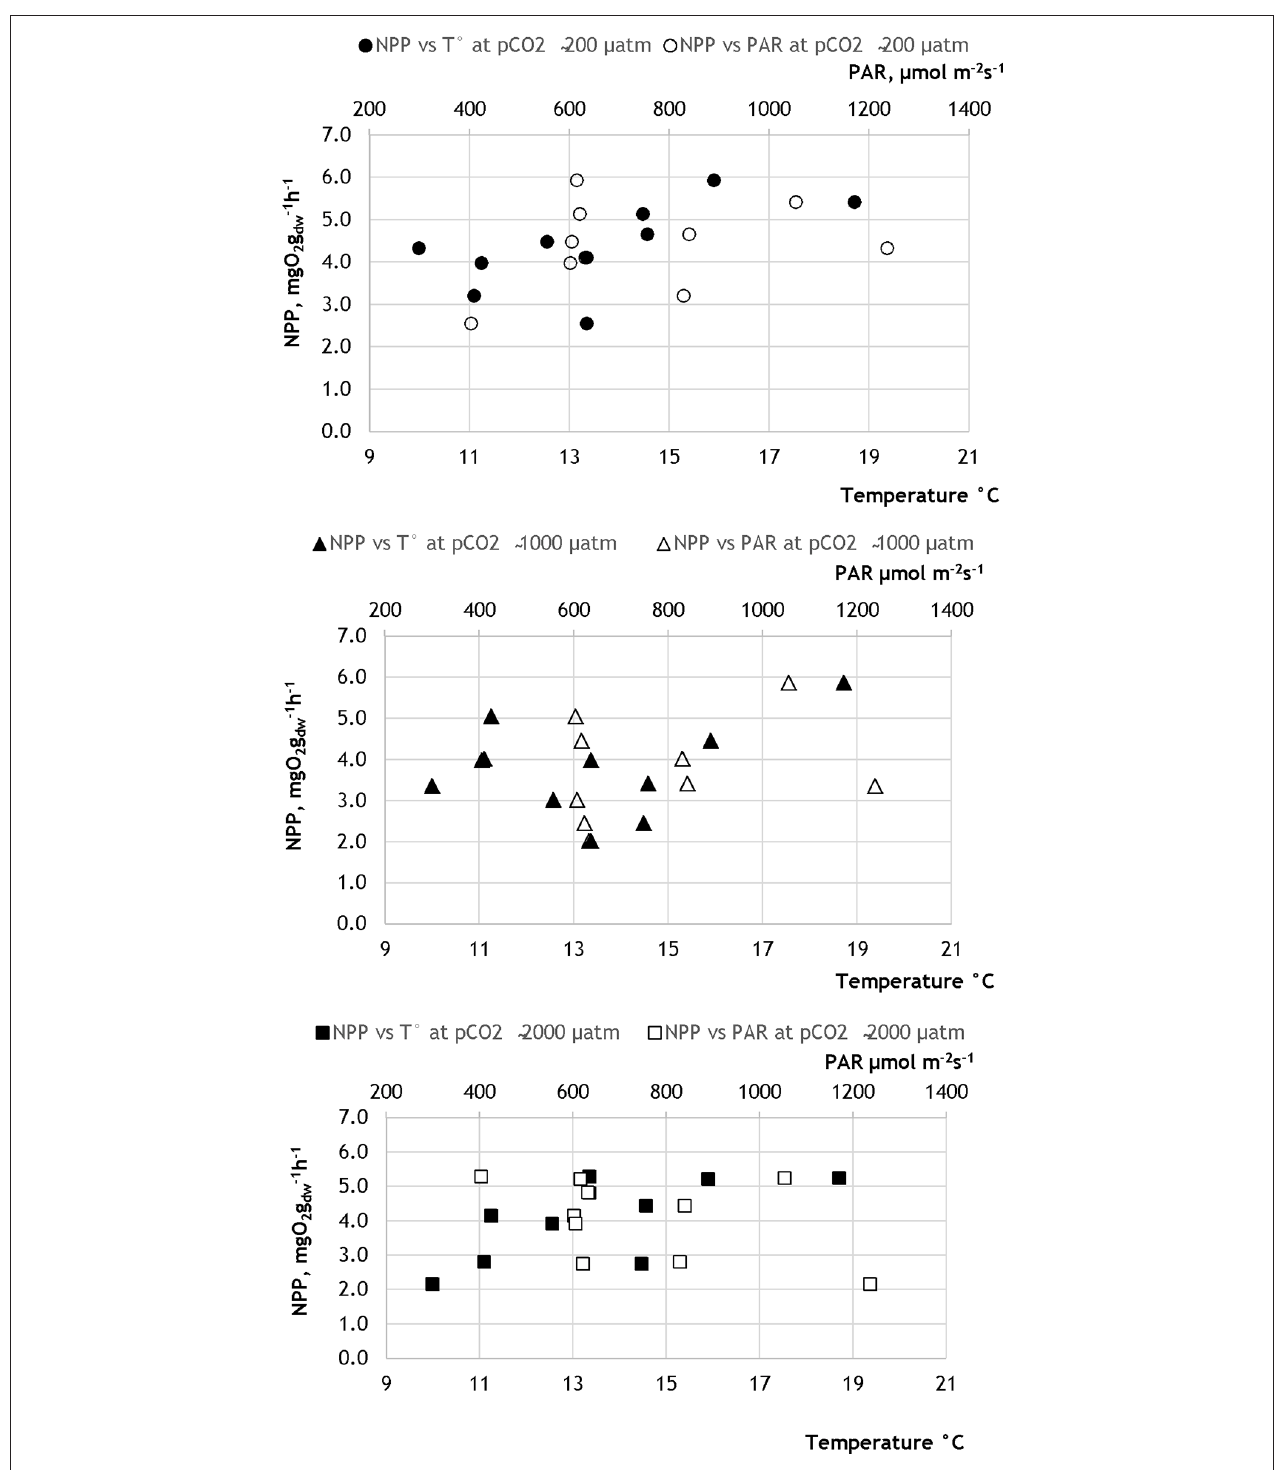
FIGURE 2 | Net photosynthesis rates (NPP) plotted against water temperature (T ◦ ) and photosynthetically active radiation (PAR) at different pCO 2 levels in 2013.